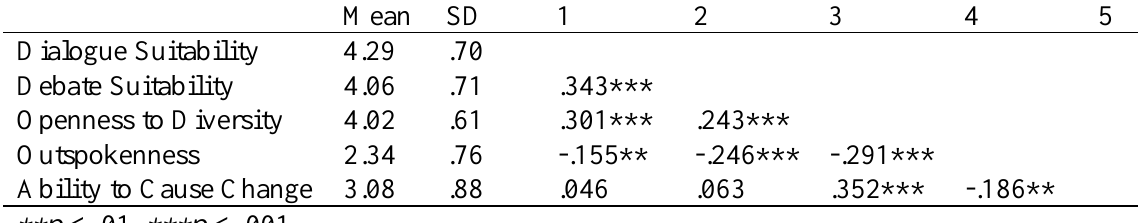
Descriptives and Correlations among Dialogue Suitability, Debate Suitability, Openness to Diversity, Outspokenness, and Ability to Cause